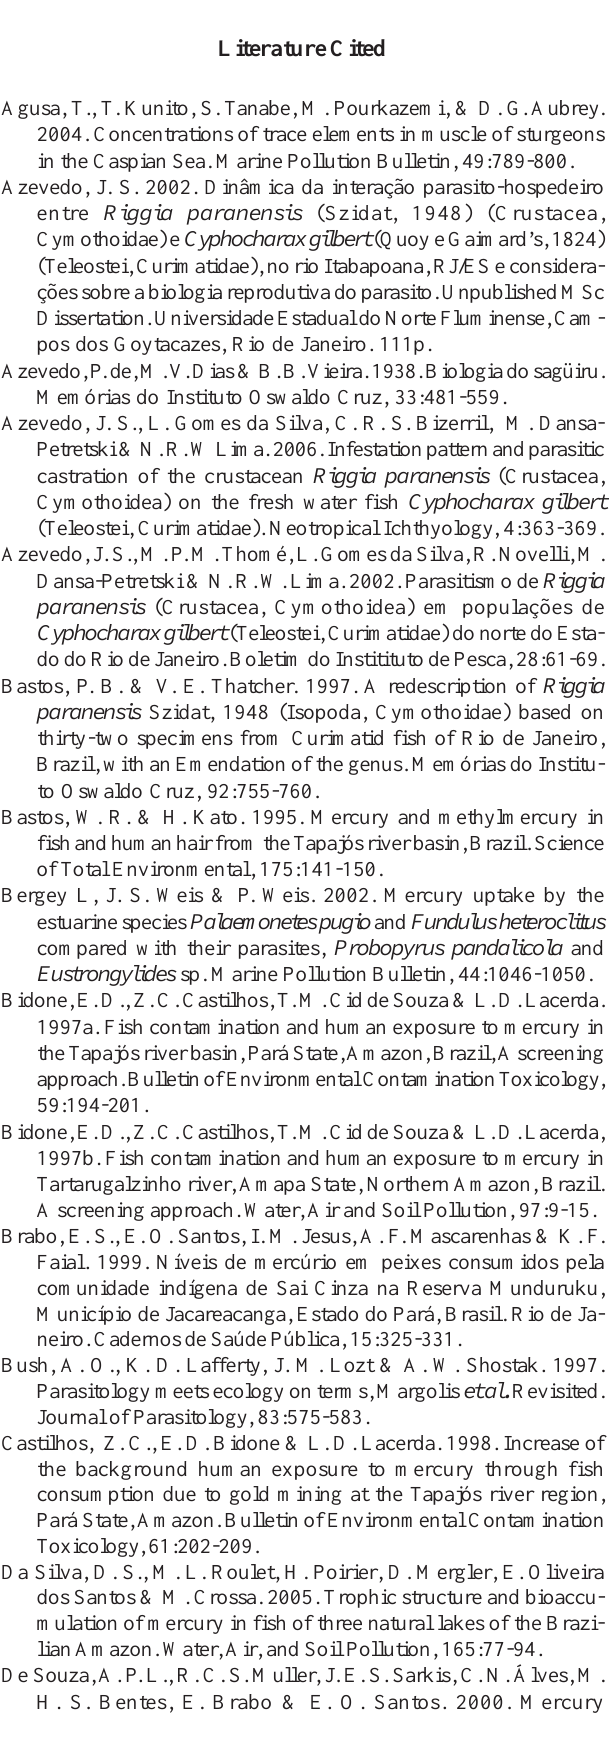
) and the levels of s